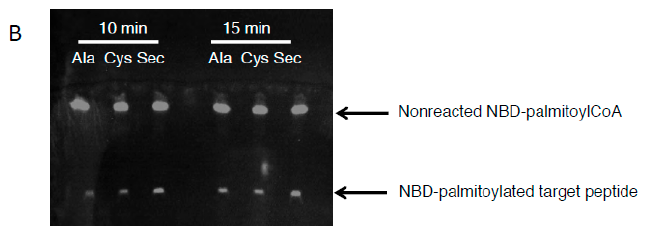
Figure 6. Acyltransferase activity of DHHC6 is most efficient when bound to Sec-containing SELENOK. The NBD-palmitoyl-DHHC6 intermediates formed at pH 7.4 were incubated with CD36 peptide (MGCDRNCK) for different periods of time. Reactions were terminated with SDS on ice and reaction products run on reverse-phase TLC, followed by analysis on a uv transilluminator to detect NBD-palmitoyl-peptide. ( A ) The first experiment was run at three time periods of 2, 5, and 10 min. ( B ) The second experiment was run for 10 and 15